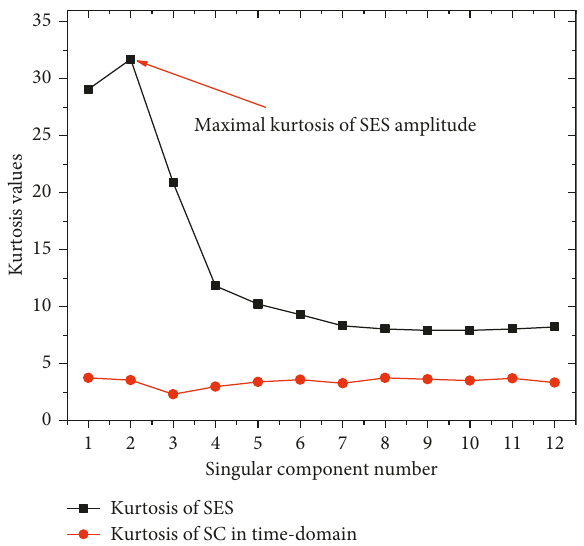
Figure 9: Kurtosis curves during SVD-KSES